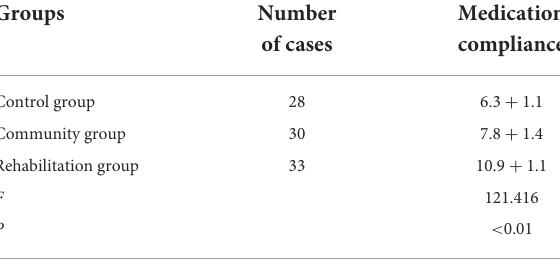
TABLE 6 Comparison of patients’ medication